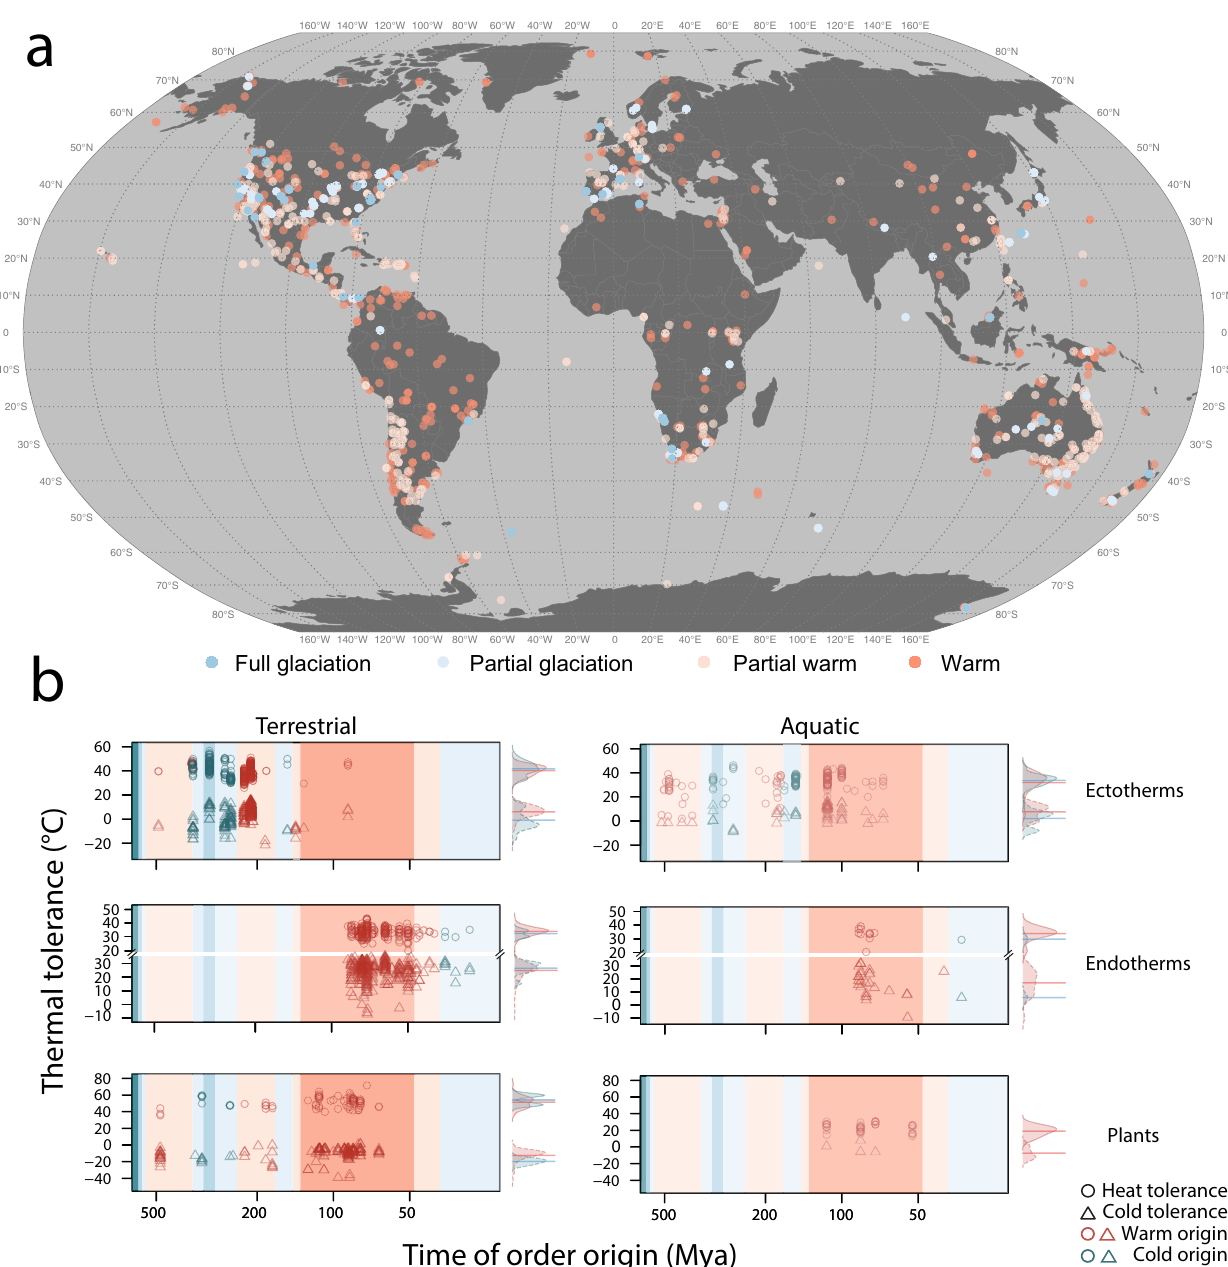
Fig. 1 A map illustrating the geographic location at which experimental specimens were collected and plots of the relationship between order age and thermal tolerance limits. Map points ( a ) and the plot area shading ( b ) are coloured according to the prevailing paleoclimate at order origin (see Supplementary Fig. 2) full glaciation (blue), partial glaciation (light blue), partial warm (light orange) and warm (orange). b The raw relationships between order age in million years (mya) and lower (triangles) and upper (circles) thermal tolerance limits for ectotherms, endotherms and plants. Points ( b ) are coloured red for species in warm origin orders (partial warm and warm palaeoclimate categories as shown in the map) and blue for species in cold origin orders (full and partial glaciation palaeoclimate categories as shown in the map). For endotherms only ( b ), the axis is broken so that upper and lower thermal limits can be clearly delineated. Density distributions of upper and lower thermal tolerance limits are shown to the right of each panel b , aggregated by time of origin, following the same colour scheme as above, lines correspond to medians. Source data are provided as a Source Data fi